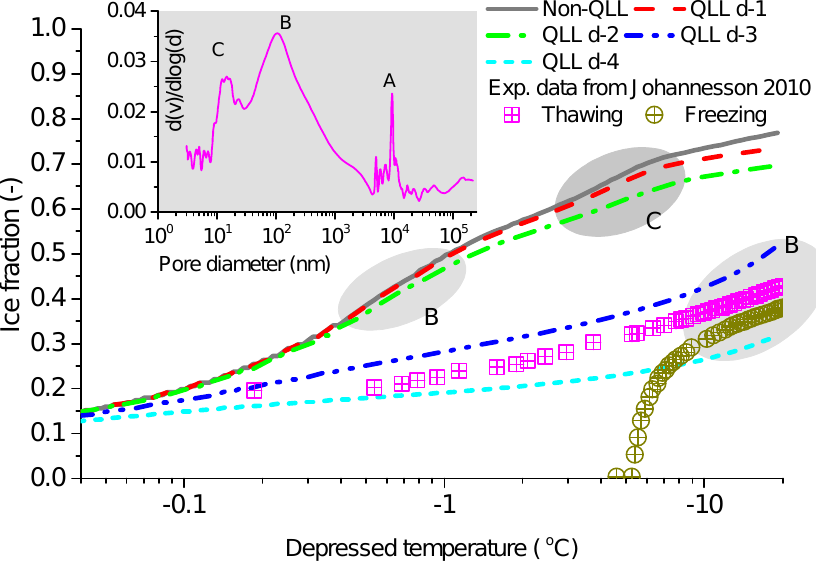
Figure 4. Ice fractions of a concrete sample (water to cement ratio of 0.6) under freezing estimated by the GT equation with the selected QLL models and the experimental ice content reported in [43]. The insert panel is the pore size distribution of the concrete determined by mercury intrusion porosimetry (MIP) with the marks A, B, and C, respectively, representing the coarse pores, capillary pores, and gels pores in the concrete sample. The shadowed areas with the same marks denotes the consequences of ice formation in those